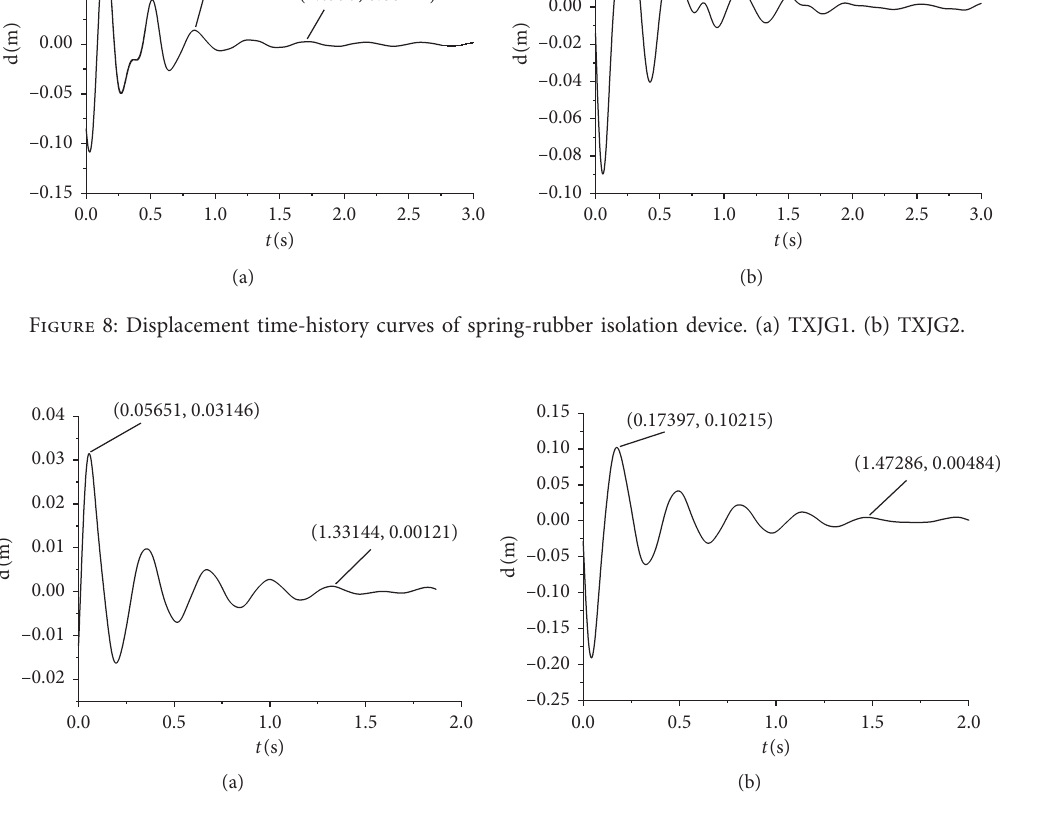
Figure 9: Displacement time-history curves of spring-aluminum foam isolation device. (a) TPMLG1. (b) TPMLG2. Table 3: Dynamic performance parameters of combined isolation